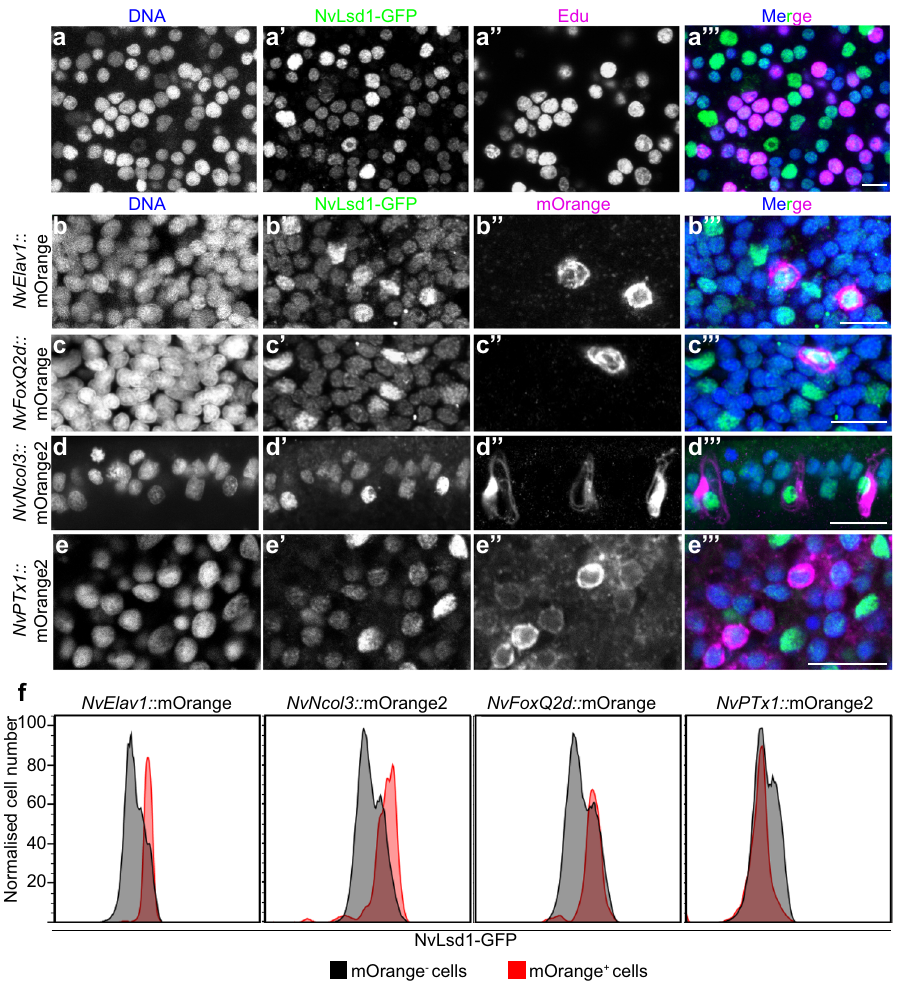
Fig. 2 NvLsd1 is highly expressed in differentiated neural cells. a Confocal images showing close up of the ectoderm of NvLsd1 GFP late gastrula pulse labeled with EdU for 4 h stained with anti-GFP antibody (green) and Click-IT EdU (Magenta). DNA is shown in blue. b – e Confocal images of immuno fl uorescence staining on late planula of NvLsd1 GFP animals crossed with NvElav1 ::mOrange ( b ), NvFoxQ2d ::mOrange ( c ), NvNcol3 ::mOrange2 ( d ) and mid-planula crossed with NvPTx1 ::mOrange2 ( e ) transgenics. DNA is shown in blue, GFP in green and mOrange in magenta. Images shown are representative samples from at least two independent replicates with >10 animals per replicate. f Histograms of fl ow cytometry data on NvLsd1 GFP animals crossed to the indicated transgenic lines. The X -axis shows the GFP fl uorescence levels (arbitrary units), the Y -axis shows the cell number normalized to mode to correct for the different numbers of cells in the mOrange + and mOrange - gates. Scale bars: 20 μ